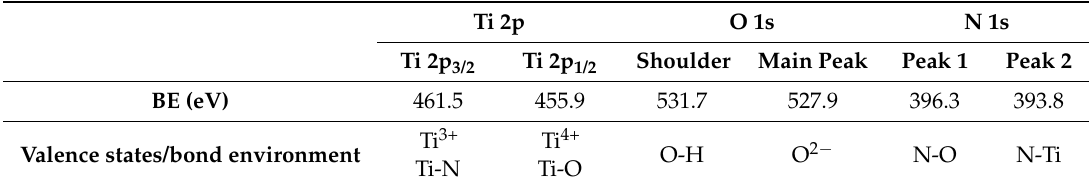
Table 1. XPS details of Ti 2p, O 1s, and N 1s peaks in amorphous N-TiO 2 films annealed at 200 ◦